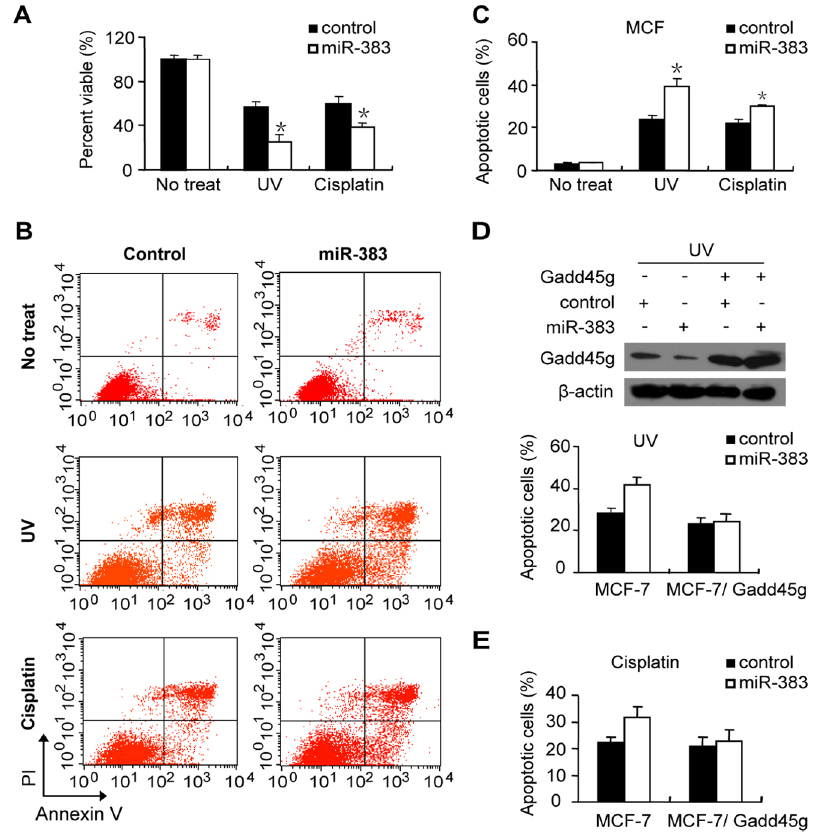
Figure 3. miR-383 regulates cellular apoptotic sensitivity to genotoxic stress through targeting Gadd45g. (A) MTT assays were performed in miR-383 mimic or a control plasmid transfected MCF-7 cells following treatment with UV irradiation (60 J/m 2 , post 12 h) or cisplatin (25 m M, post 24 h). (B) Apoptosis was analyzed by Annexin V/PI assays in MCF-7 cells transfected with miR-383 mimic or control followed by with UV irradiation or cisplatin treatment. Percentage of apoptotic cells was shown at bottom. (C) MCF-7 cells were co-transfected with miR-383 mimic or control and Gadd45g expression plasmid without the 3 9 -UTR. After transfection, cells were treated by UV irradiation (60 J/m 2 , post 12 h). Gadd45g levels were reduced by miR- 383 mimic, and rescued by the Gadd45g expression plasmid (top). Apoptosis was analyzed by Annexin V/PI assay (bottom). (D) MCF-7 cells were co-transfected with miR-383 mimic or control and Gadd45g expression plasmid without the 3 9 -UTR, and treated with cisplatin (25 m M, post 24 h). Apoptosis was analyzed by Annexin V/PI